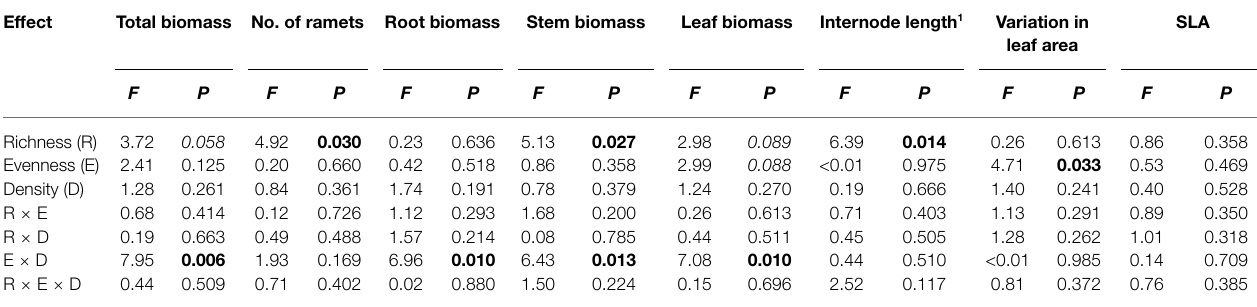
TABLE 1 | Effects of genotypic richness (4-genotype vs. 8-genotype), genotypic evenness (low vs. high evenness), and plant density (low vs. high density) on total biomass, root biomass, creeping stem biomass, leaf biomass, number of ramets, internode length, variation in leaf area, and specific leaf area (SLA) of Hydrocotyle vulgaris population. Effect Total biomass No. of ramets Root